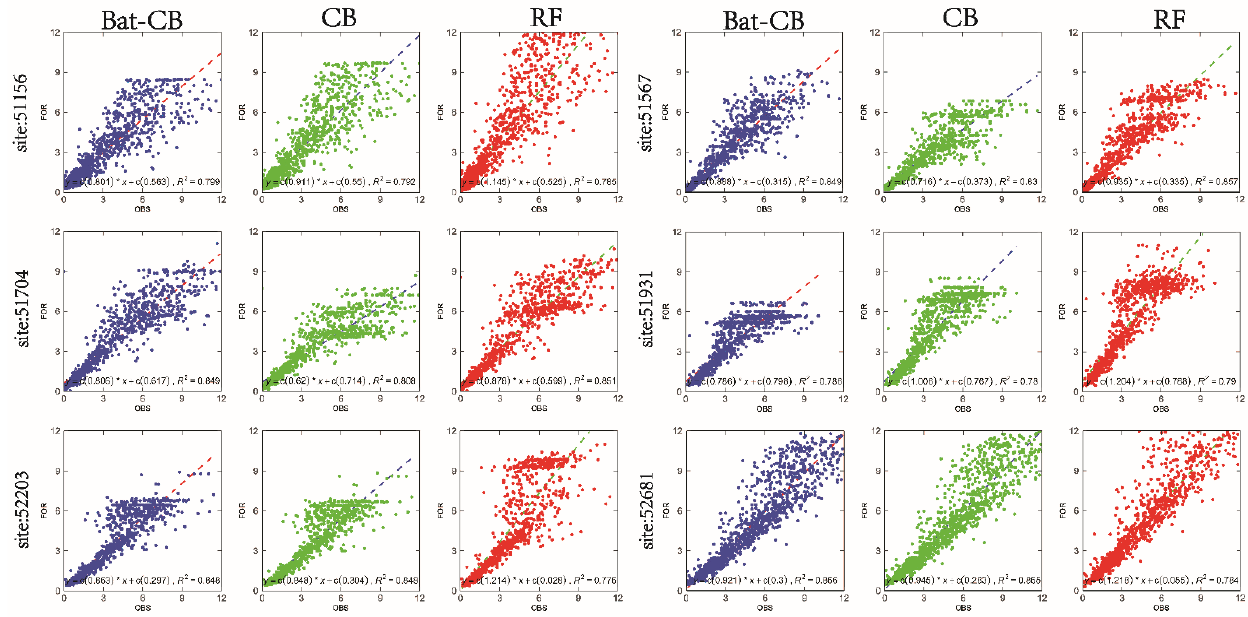
Figure 4. Scatterplots of observed (OBS) and forecasted (FOR) pan evaporation generated from the three models applied at the 6 randomly selected stations in the testing period. Each panel shows the linear regression fit and the coefficient of determination ( R 2 ).